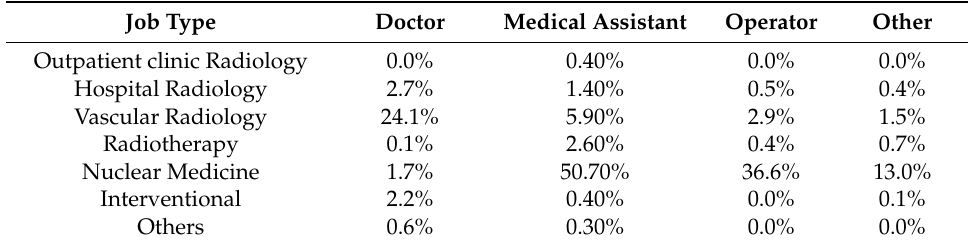
Table 2. Percentage of healthcare workers exceeding the annual dose limit according to their job